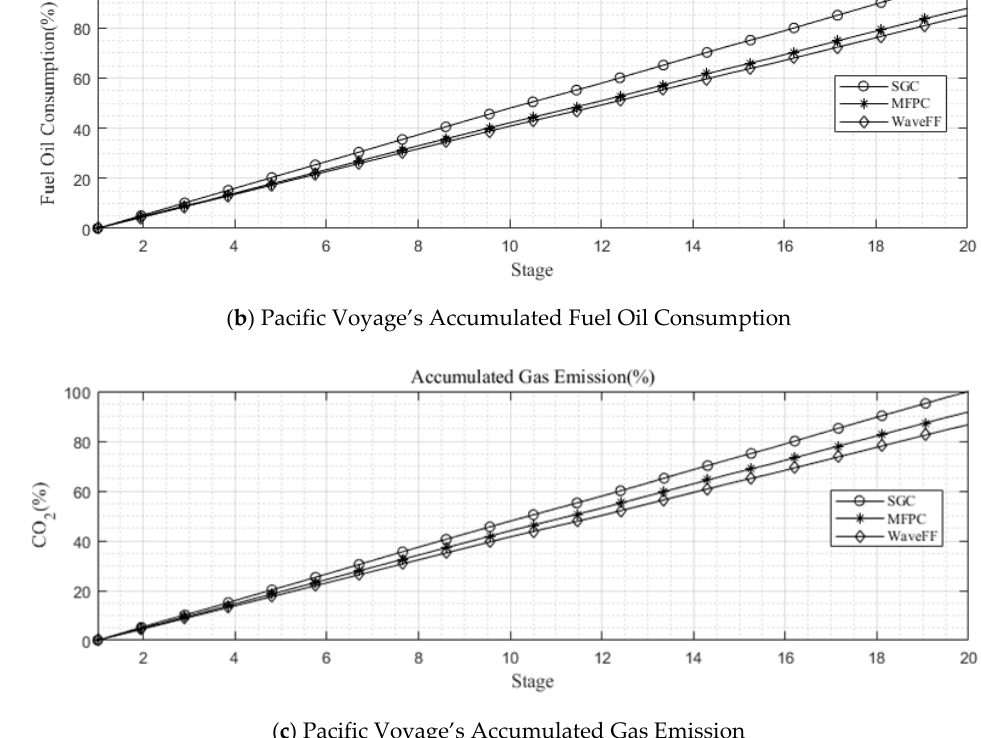
Figure 16. Pacific voyage planning results.